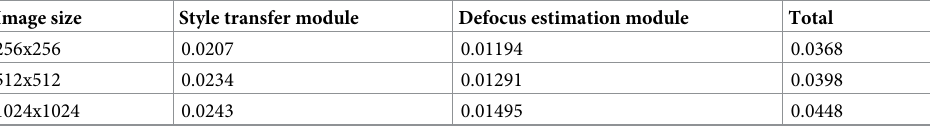
Table 3. Time performance table of each module under different image sizes (unit,